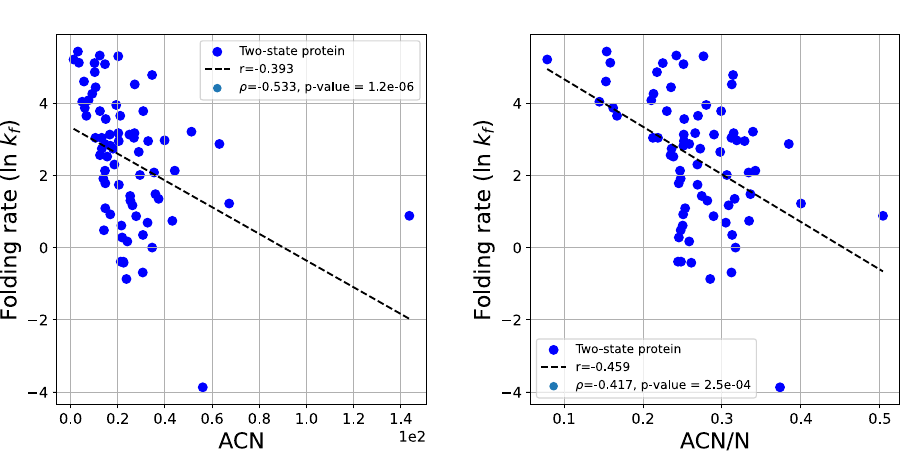
Figure 8. The protein folding rate as a function of the ACN (left) and ACN/N (right) of the set of two-state proteins. This set excludes the protein 1l8w which had an outlying ACN of about 140. When included the correlation decreases to r = − 0.48 .